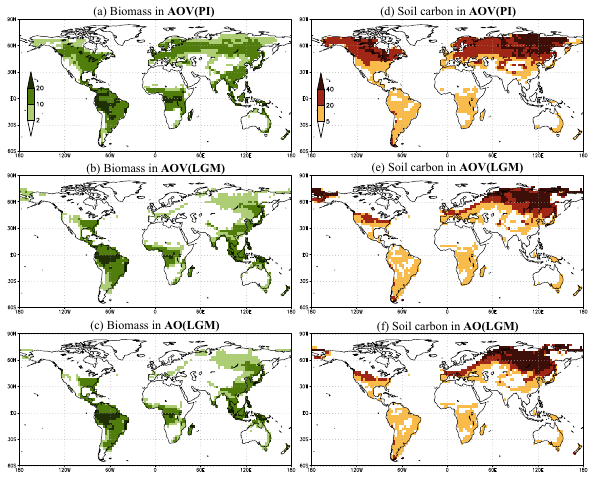
Fig. A2. As same as Figure7 but absolute biomass [kg/m 2 ] in (a) AOV(PI) , (b) AOV(LGM) and Fig. A2. The same as Fig. 7 but absolute biomass [kgm − 2 ] in (a) (c) AO(LGM) and soil carbon [kg/m 2 ] in (d) AOV(PI) , (d) AOV(LGM) and AO(LGM) . AOV(PI), (b) AOV(LGM) and (c) AO(LGM) and soil carbon [kgm − 2 ] in (d) AOV(PI), (d) AOV(LGM) and